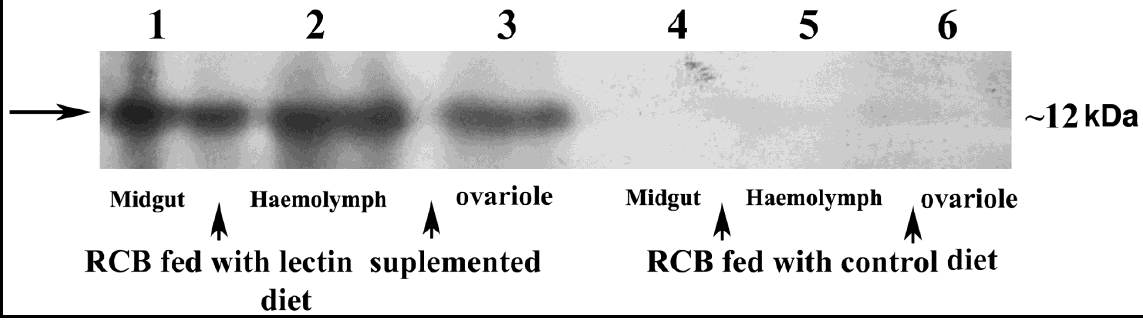
Figure 2. Western blotting showing the presence of CEA in the midgut, haemolymph and ovary of the lectin supplemented diet fed RCB. Lane 1, 2 and 3: total protein extract (30 µg) from lectin fed RCB midgut, haemolymph and ovary showing CEA band at ~12 kDa. Lane 4, 5 and 6: total protein extract (30 µg) from control diet (without lectin) fed RCB midgut, haemolymph and ovary showing no CEA band represented as negative